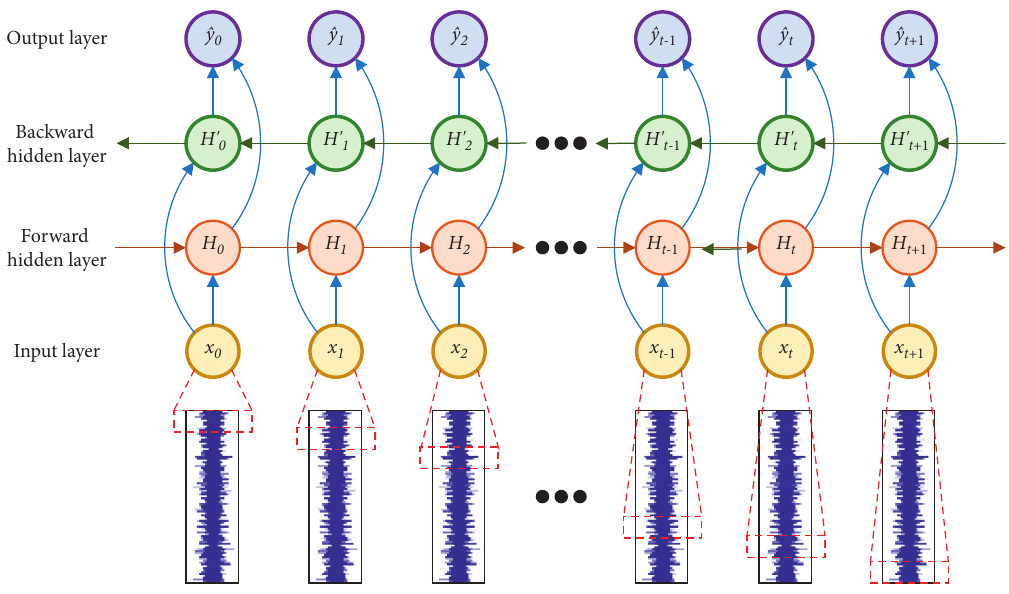
Figure 1: Basic structure of a